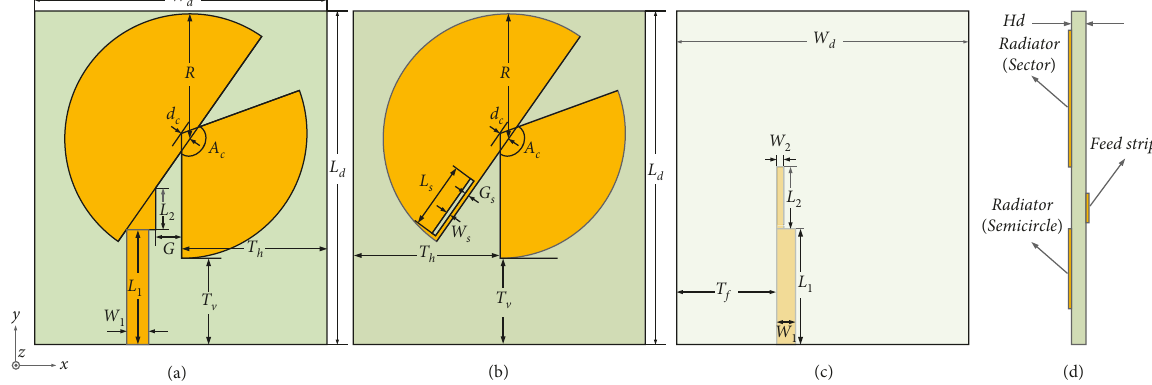
1 and J 2 at 3.3GHz; (b) J 1 and J 4 at